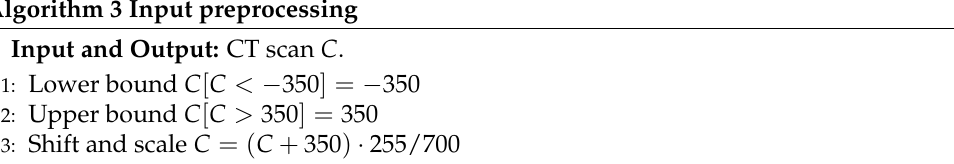
Algorithm 3 Input